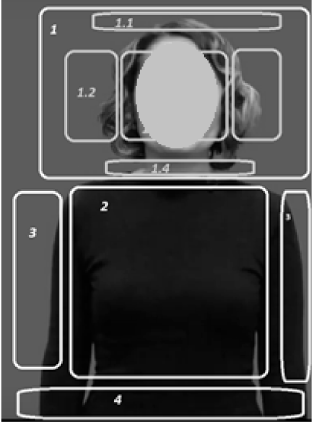
Figure 2. Localization.